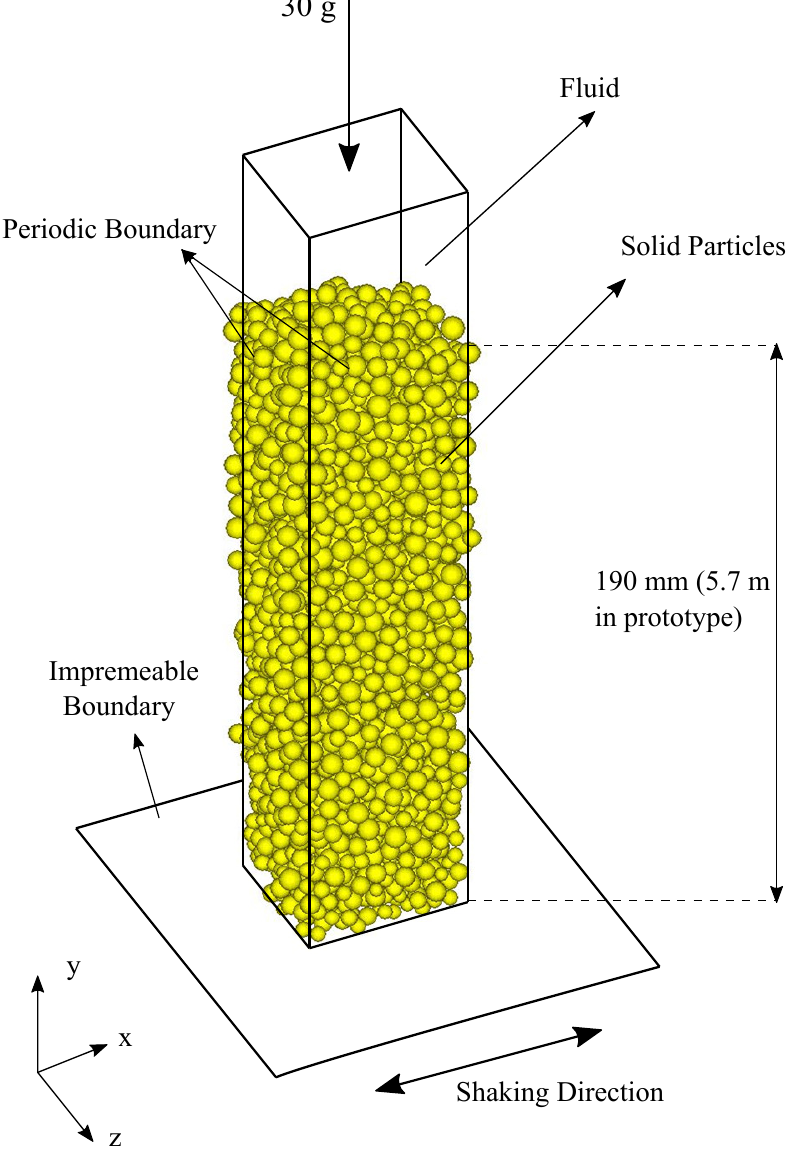
Figure 5. 3-D view of the particle